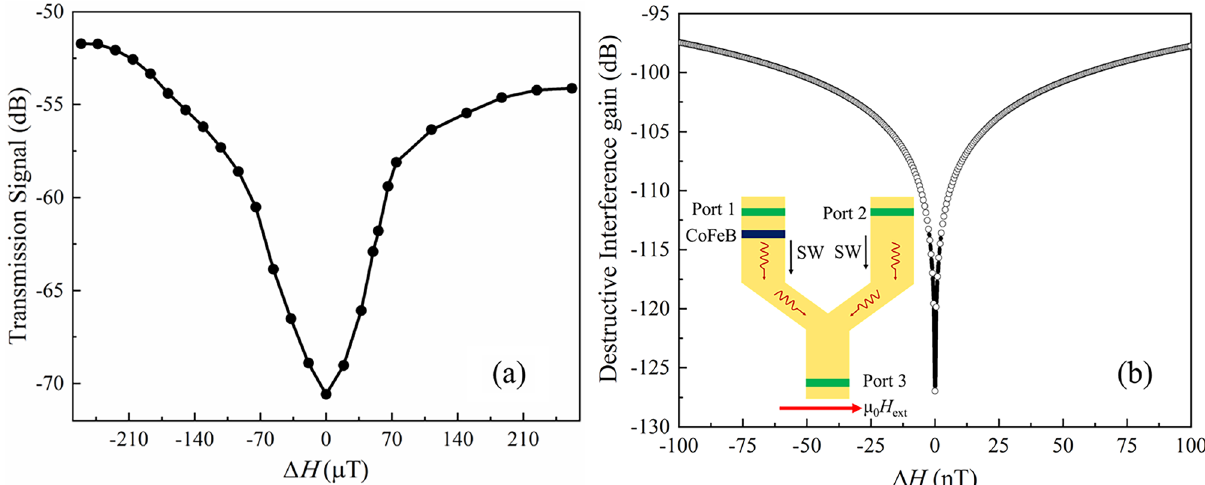
Figure 3. ( a ) Perturbation field ∆ H -dependent transmission signal intensity. ∆ H has been extracted from the sharp band gap of Fig. 2a, indicated by the black dotted rectangle in conjunction with the Kittel equation. ( b ) Theoretical calculation of interference gains at the destructive interference position vs. the nano Tesla sensing field of the proposed Y-shaped interference device shown in the (inset of the